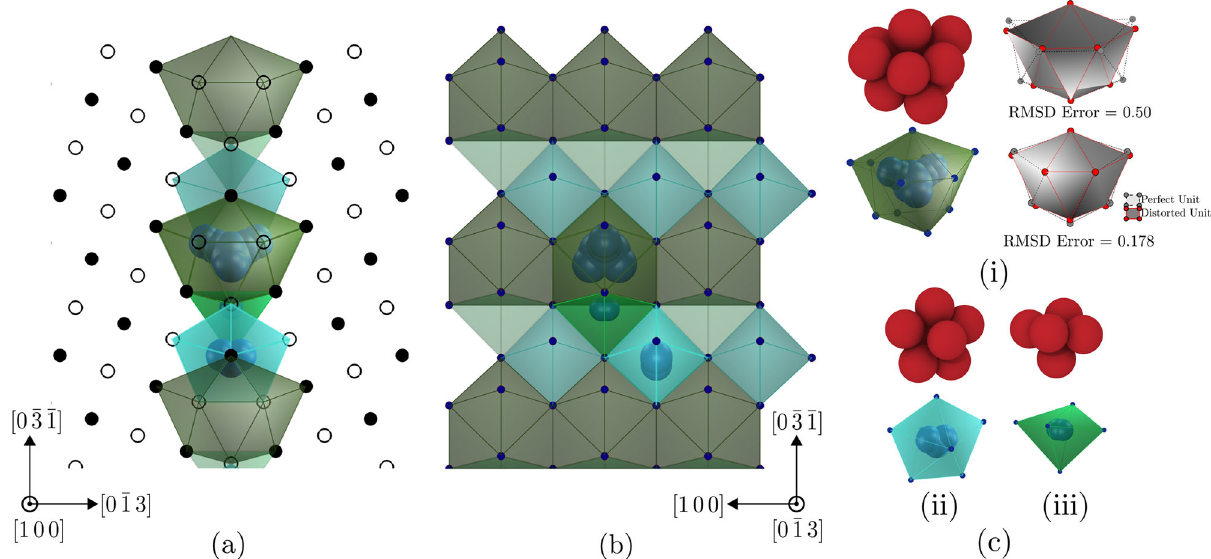
Fig. 3 The polyhedral unit model of the Σ 5 ð 013 Þ GB is illustrated. a , b The atomistic structure and the polyhedral units of the symmetric-tilt GB are shown, as viewed along the tilt axis [100] and the plane normal ½ 0 13 (cid:5) , respectively. The polyhedral units corresponding to the smallest asymmetric unit (the unit-cell) are highlighted. c The unit-cell polyhedral units, which include (i) the Octadecahedron, (ii) the pentagonal bi- pyramid and (iii) the dual-tetrahedron along with the overlapping VV-spheres (Bernal holes) are illustrated. Also shown in c (i) is the comparison between the observed GB unit and the perfect Octadecahedron (RMSD error is equal to 0.5) and the Σ 5 0 21 Octadecahedron (RMSD error is approximately equal to